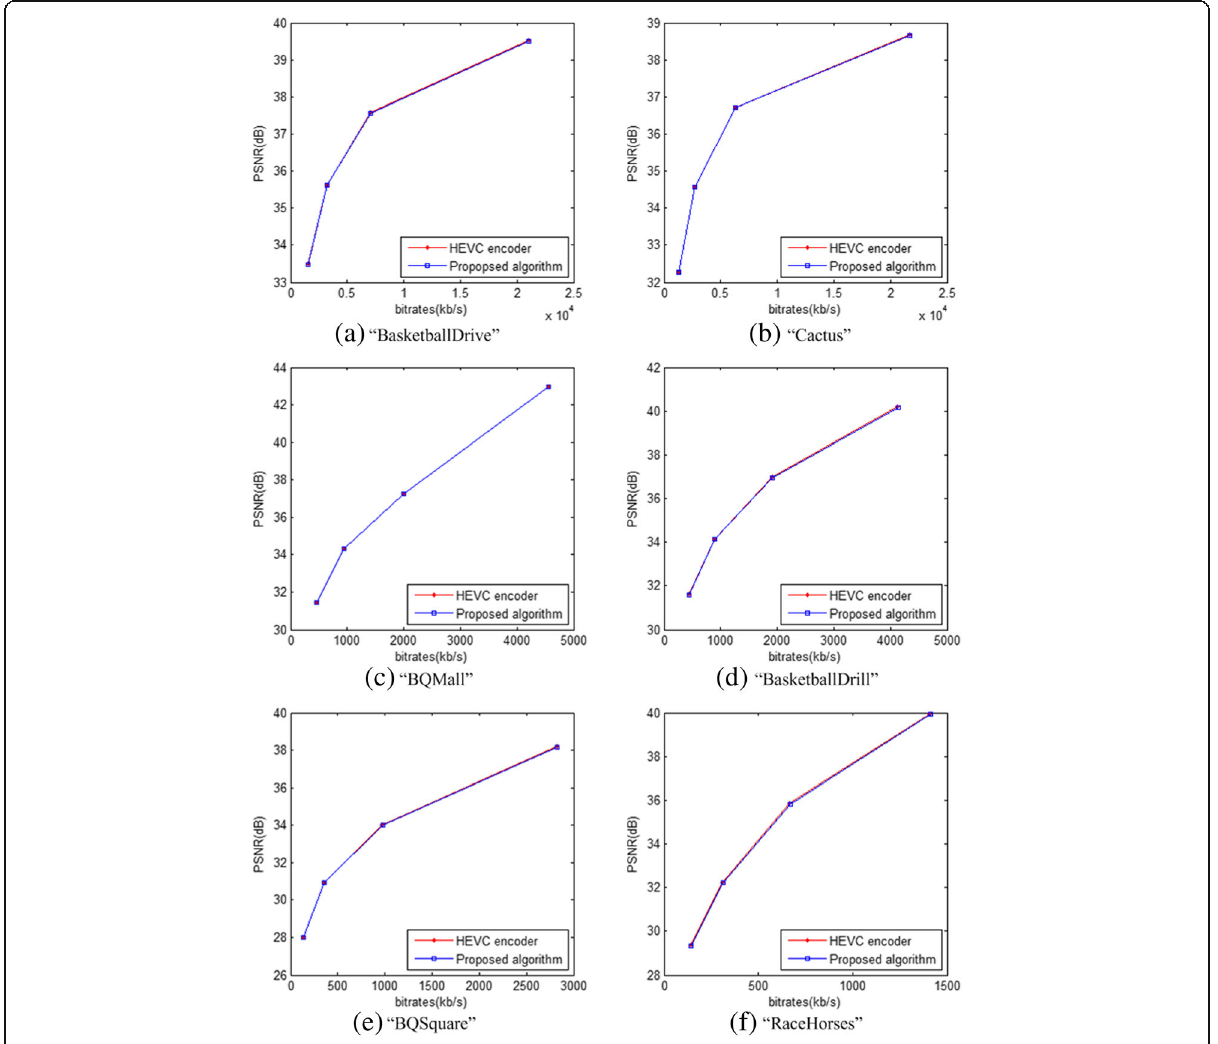
Fig. 7 RD curves with the QP of 22, 27, 32 and 37 under LDP configuration. a “ BasketballDrive ” . b “ Cactus ” . c “ BQMall ” . d “ BasketballDrill ” . e “ BQSquare ” . f “ RaceHorses